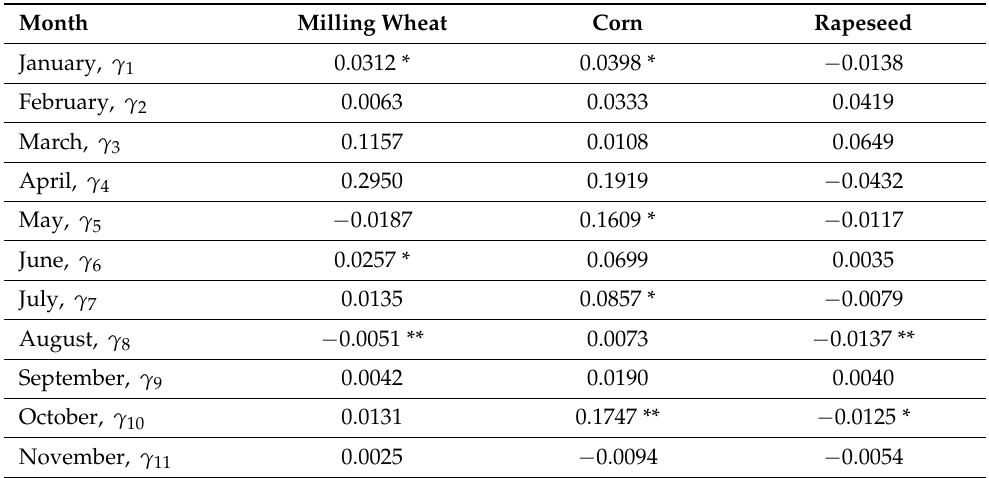
Table 4. Estimates from the GARCH month selection model for agricultural